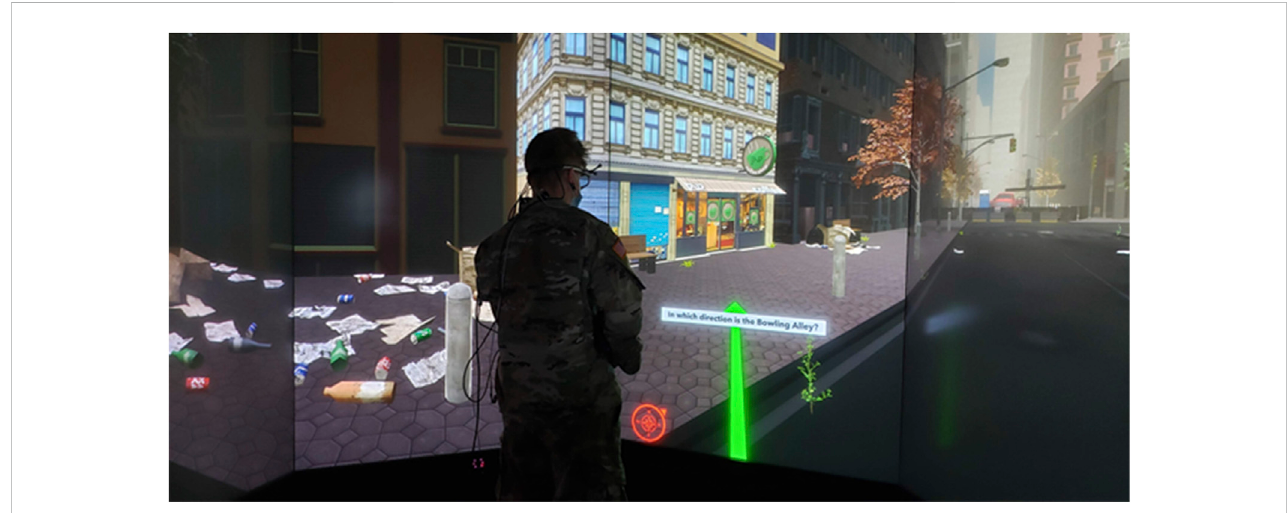
FIGURE 4 An example trial during the SOT, during which the participant is placed adjacent to a landmark (e.g., coffee shop ) and is asked to point in the general direction of a target landmark (e.g., bowling alley ). Compass rose depicted at lower